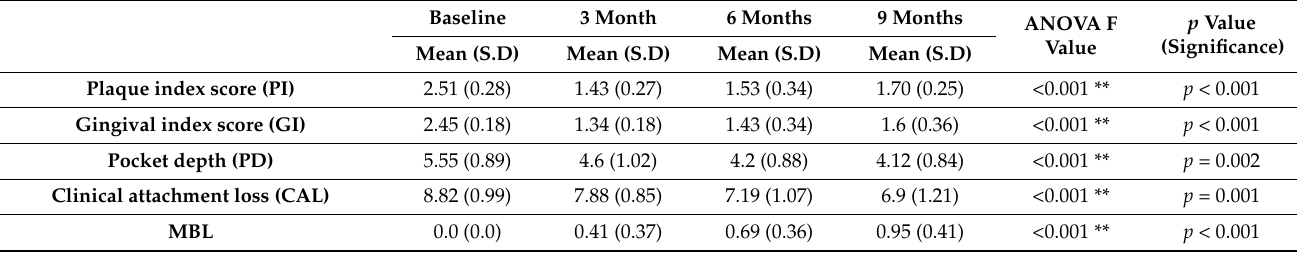
Table 1. Intragroup comparison of clinical parameters of test group.